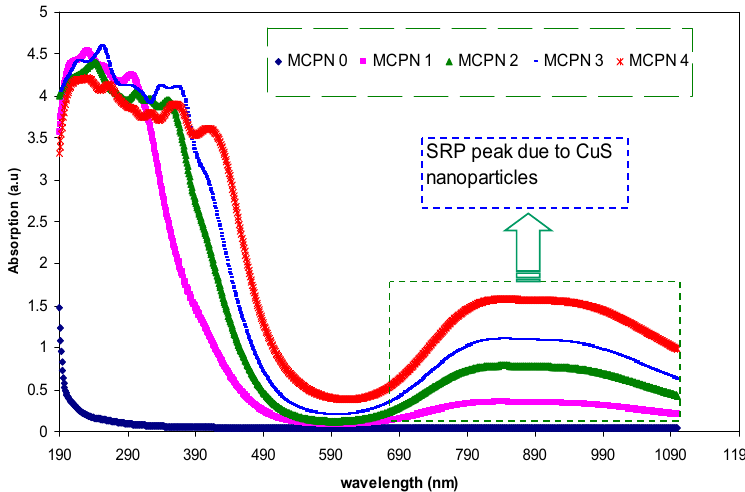
Figure 2. The absorption spectra of pure MC and MC nano-composite samples. Figure 2.